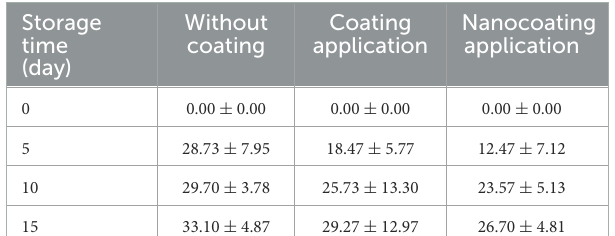
TABLE 1 Weight loss of Siamese